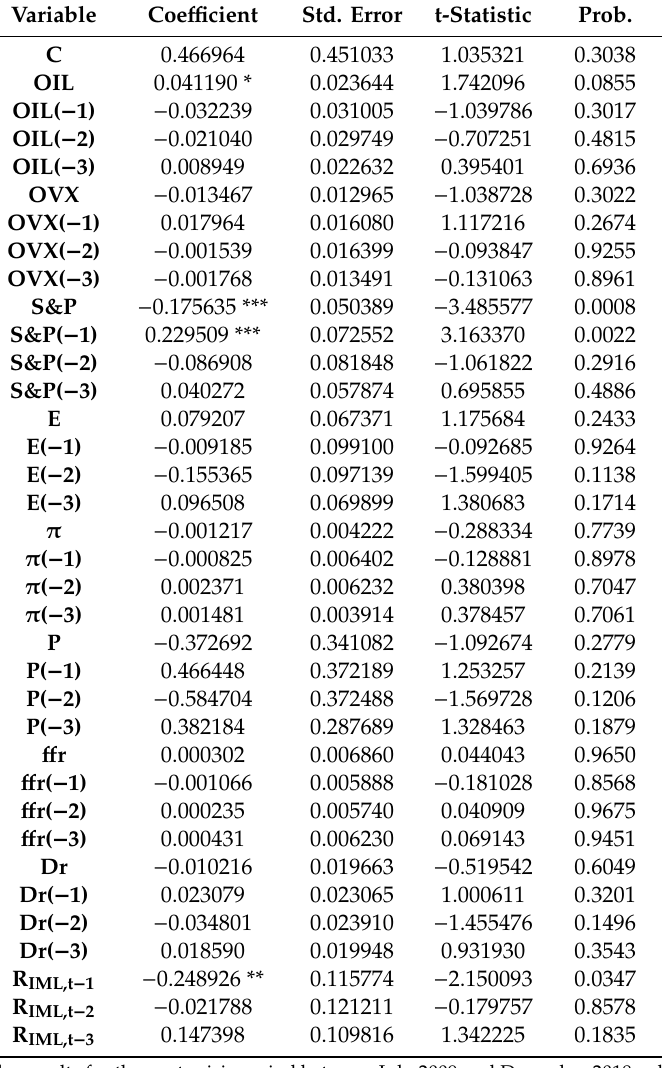
Table 21. Long-run ARDL model